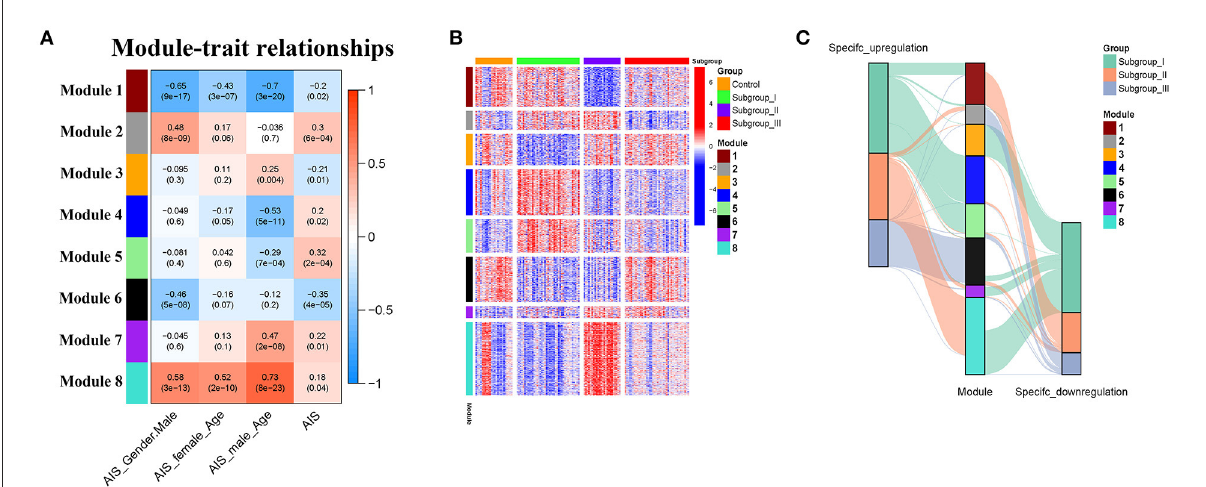
FIGURE5 Identification and characterization of 8 modules by weighted gene co-expression analysis (WGCNA). (A) Module-trait relationship of gender and age in male and female patients. The positive and negative correlation coefficients of WGCNA modules and clinical characteristics are colored from red to blue. Each row corresponds to a module eigengene, each column corresponds to a trait. Each cell depicts the corresponding Pearson correlation r-values and p values in the bracket. (B) The scaled expression values of genes in each of the 8 WGCNA modules are displayed in the heatmap. (C) Alluvial diagram showing the inherent relationship between modules and subgroups.